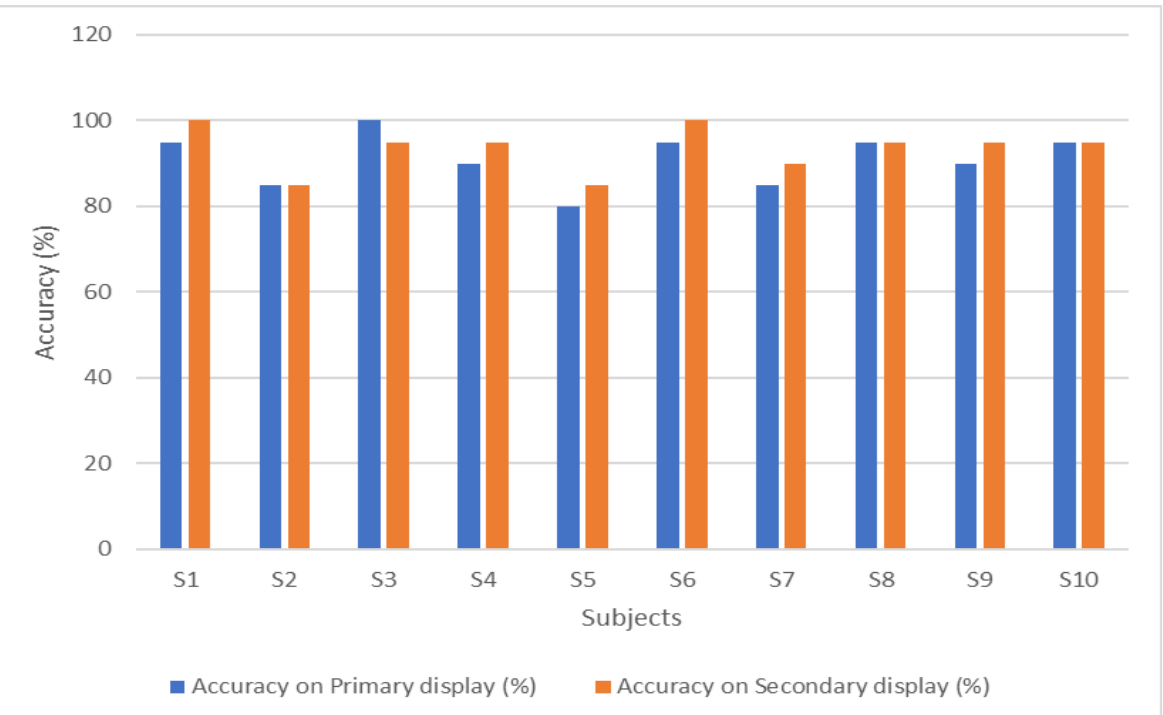
Figure 9. Comparison of the classification accuracies for both the displays.